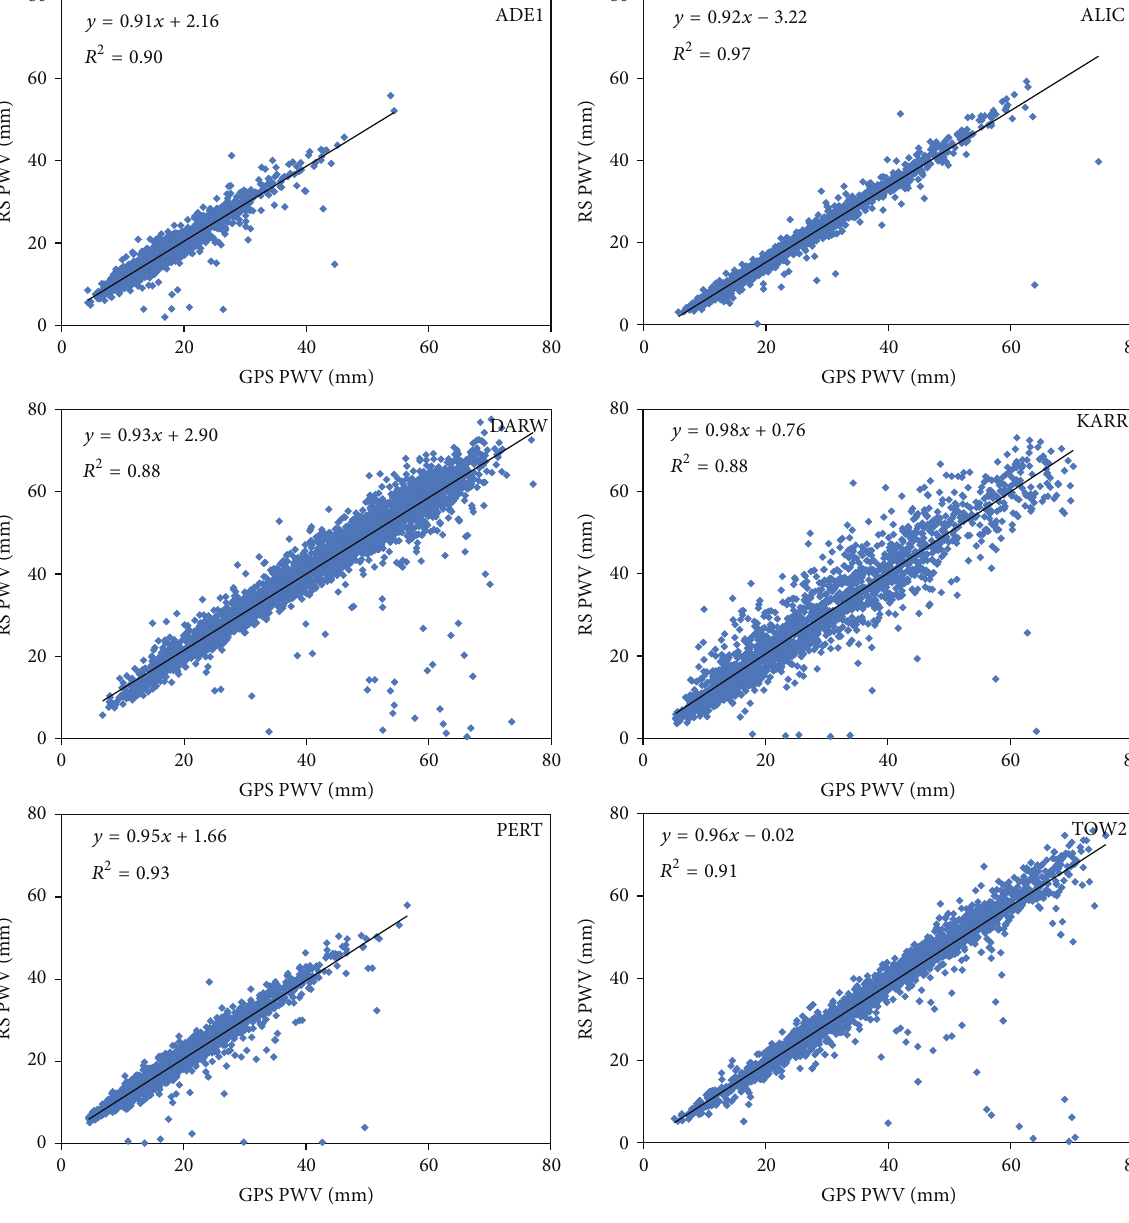
Figure 5: Scatterplots of GPS versus radiosonde measurements of